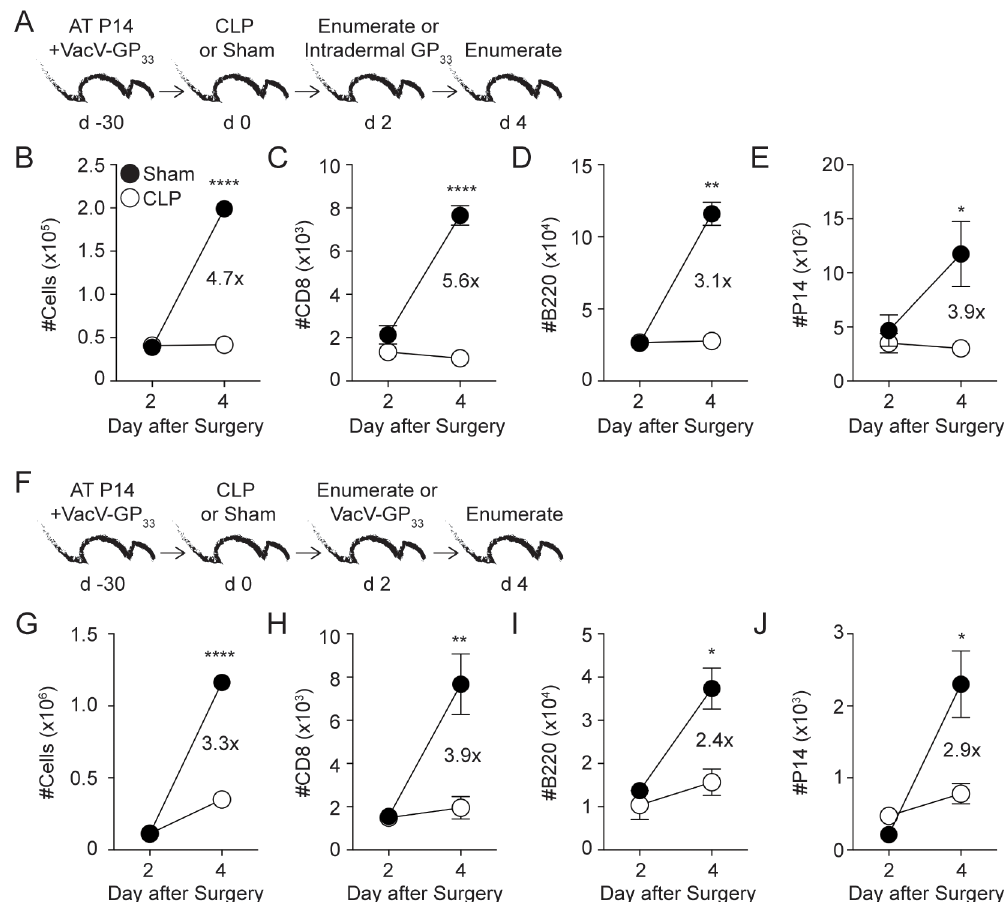
Fig 3. Sepsis impairs bystander recruitment of circulating cells to the skin upon Ag-dependent activation of skin CD8 T RM . (A, F) ExperimentalDesigns. 10 4 na ï veP14 CD8 T cells (Thy1.1) were adoptively transferred into C57Bl/6recipienthosts (Thy1.2) followedby VacV-GP 33 infectionof the left ear. After 30 days mice underwent CLP or sham surgery. Mice receivedan intravascular injectionof CD45.2 mAb 2 days later, and cells within the left ear were enumerated or mice receivedintradermalinjectionof 50 μ gof GP 33-41 peptide(A) or homologous VacV-GP 33 infection(F) in the left ear. The peptideinjected or VacV infected mice then receivedan intravascular injectionof CD45.2mAb 2 days later and cells within the left ear were enumerated. (B) Total cell count and number of (C) CD8 +CD45.2-, (D) B220+CD8-CD45.2- or (E) P14 CD45.2- cells before and after skin T RM -mediated bystander recruitment to the ear, day 2 and 4, respectively. (G) Total cell count and number of (H) CD8+ CD45.2-, (I) B220 +CD8- CD45.2- or (J) P14 CD45.2- cells before and after VacV re-challenge(day 2 and 4, respectively). Data are representative of two independentexperiments with 3–5 mice per group per experiment. * = p < 0.05; ** = p < 0.01; **** = p < 0.0001.Error bars represent the standarderror of the mean.